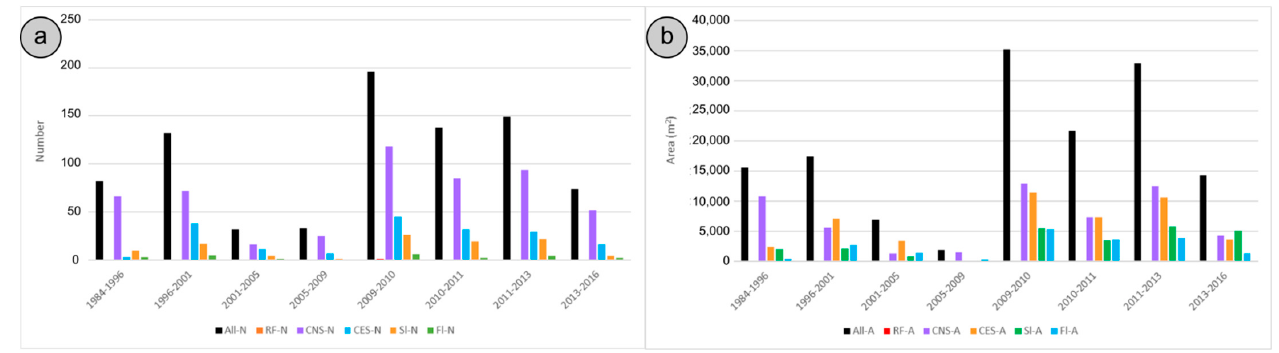
Figure 11. Activity of landslides in the different periods considered: ( a ) number of landslides (N); ( b ) total areas (A). RF: rock falls; CNS and CES: collapses in natural and engineering slopes; Sl: slides; Fl: flows.